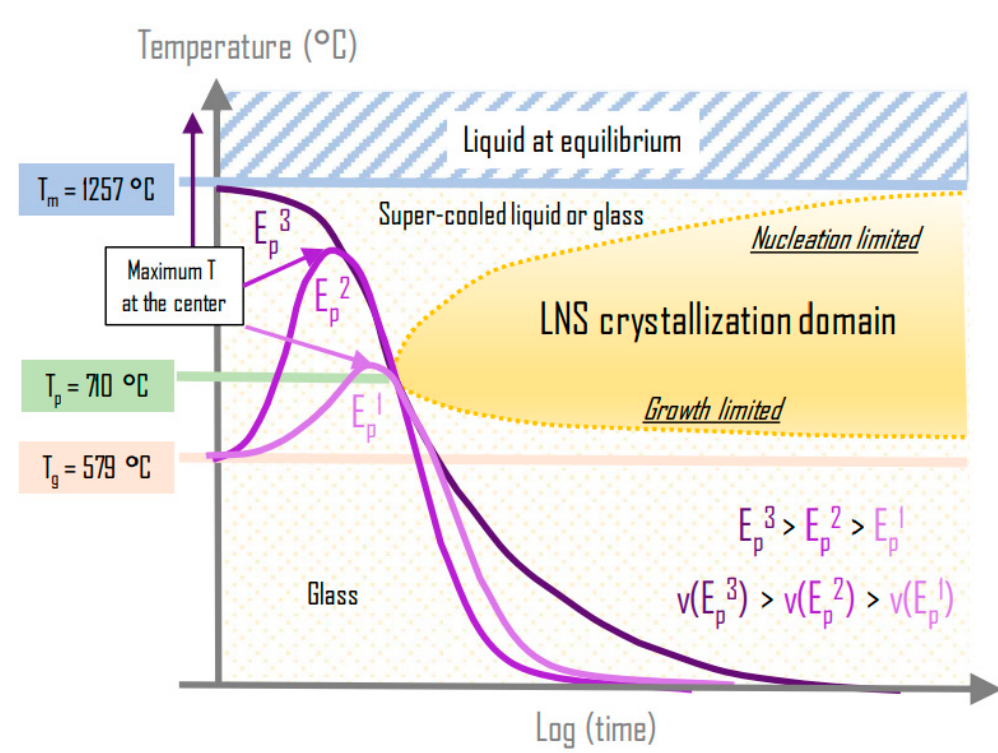
Figure 11. The figure shows the possibility of increasing the scanning speed in preserving the nanocrystal microstructure. The objective is that the treatment curve crosses the nose of the crystallization domain. If the speed is increased, the mean power must be increased in relation. Quite rapidly, the treatment curve overcomes the melting temperature, and the mechanism evolves from solid-solid to liquid-solid crystallization.